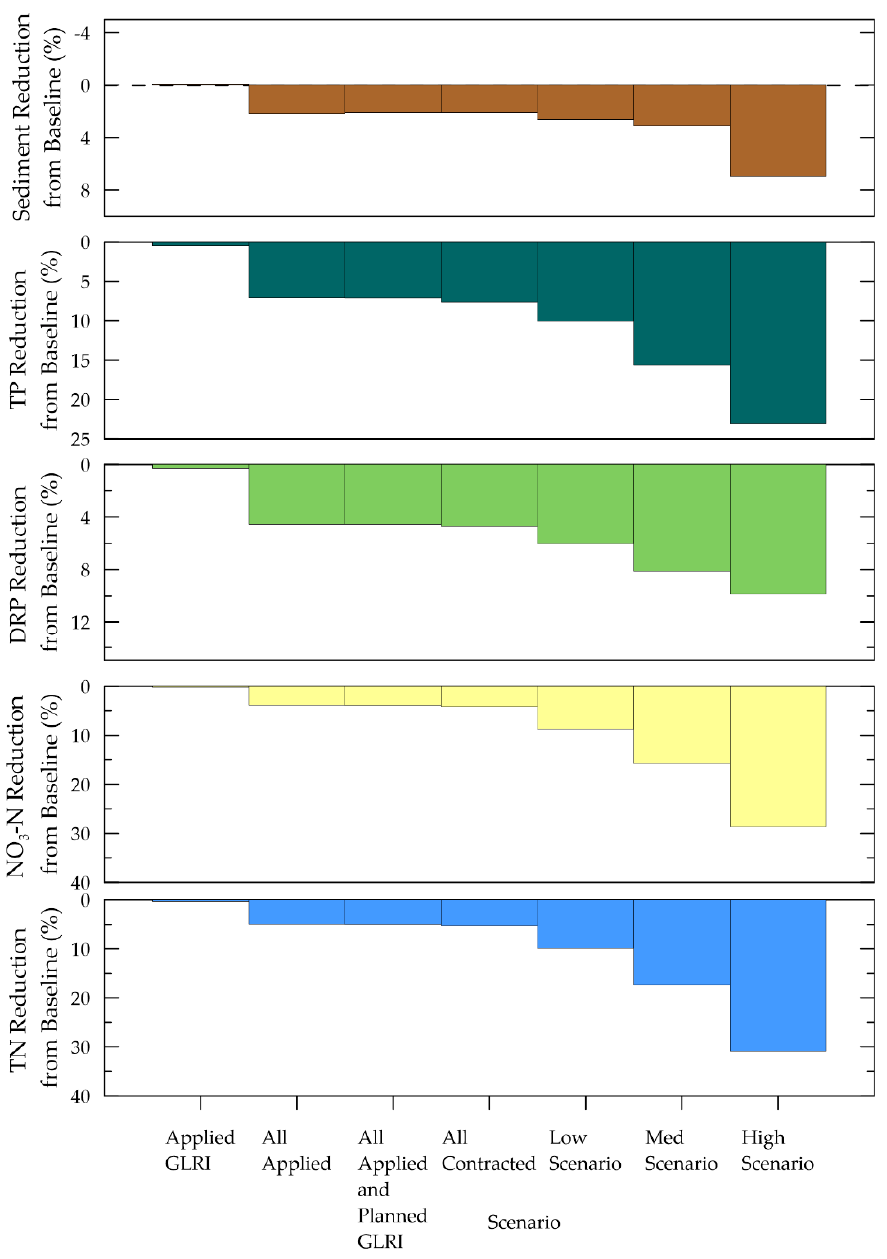
Figure 10. Percent reductions in sediment and nutrient loads by scenario at HUC12 outlet, Eagle Creek watershed, Ohio. Negative values indicate an increase in sediment or nutrients. DRP = dissolved reactive phosphorus; GLRI = Great Lakes Restoration Initiative; NO 3 -N = nitrate-nitrogen; TN = total nitrogen; TP = total phosphorus.